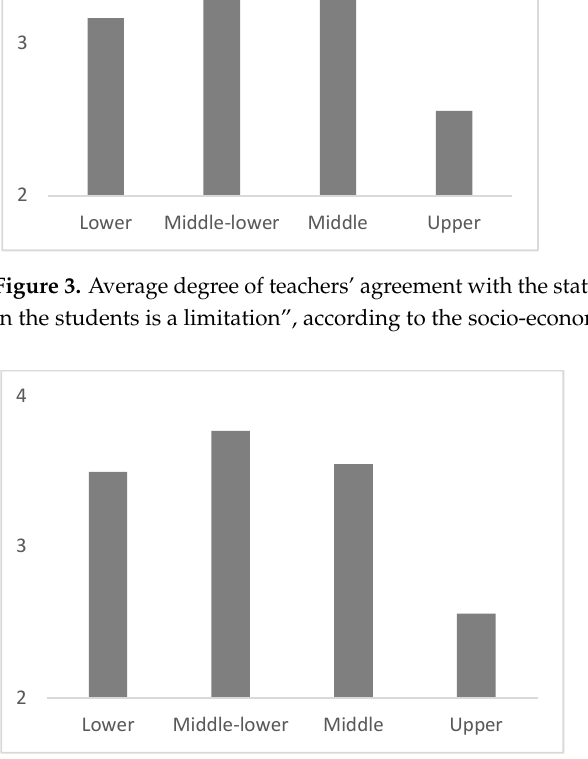
Figure 4. Average degree of teachers’ agreement with the statement “The lack of knowledge in the use of information and communication technologies by students is a limitation”, according to the socio-economic status of students.